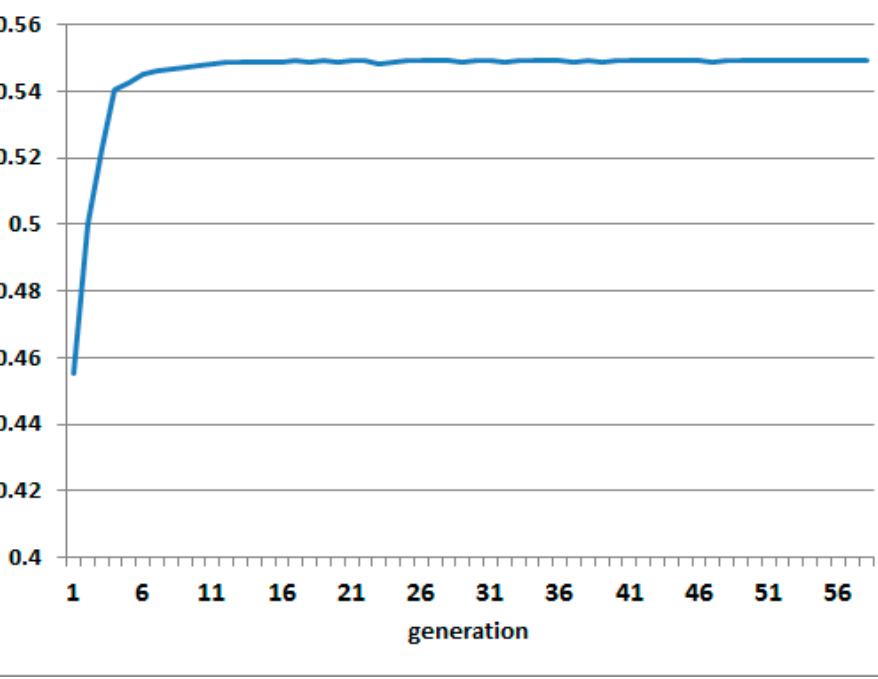
4.5.2. Result of Detection Rate and F1-Measure, ETS/CSI/PAG/ACC